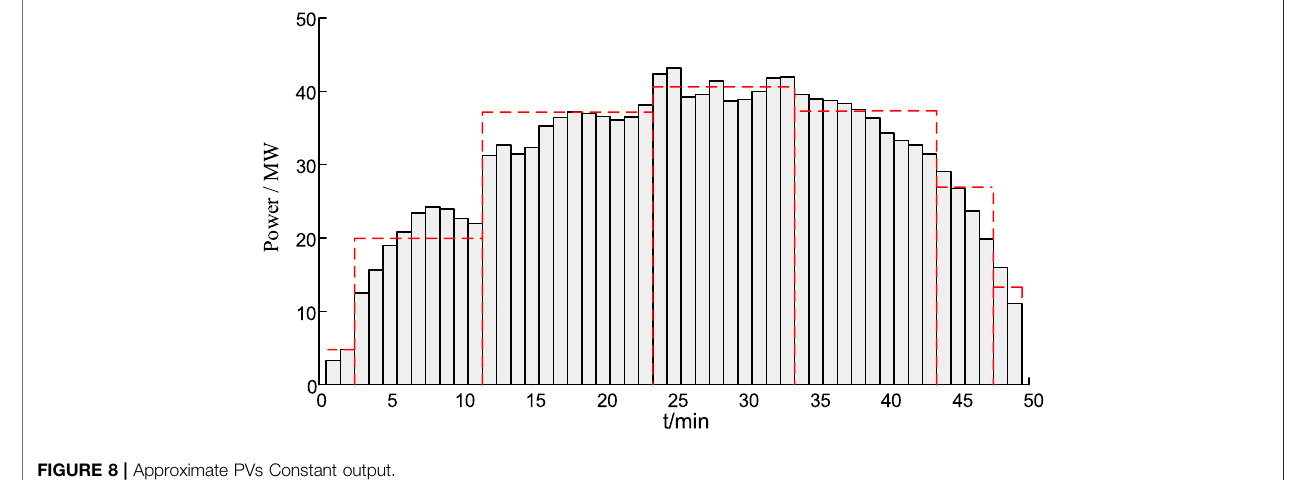
FIGURE 8 | Approximate PVs Constant output.